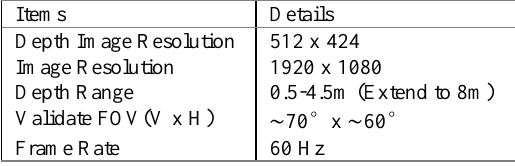
Figure 1. Sensor profile